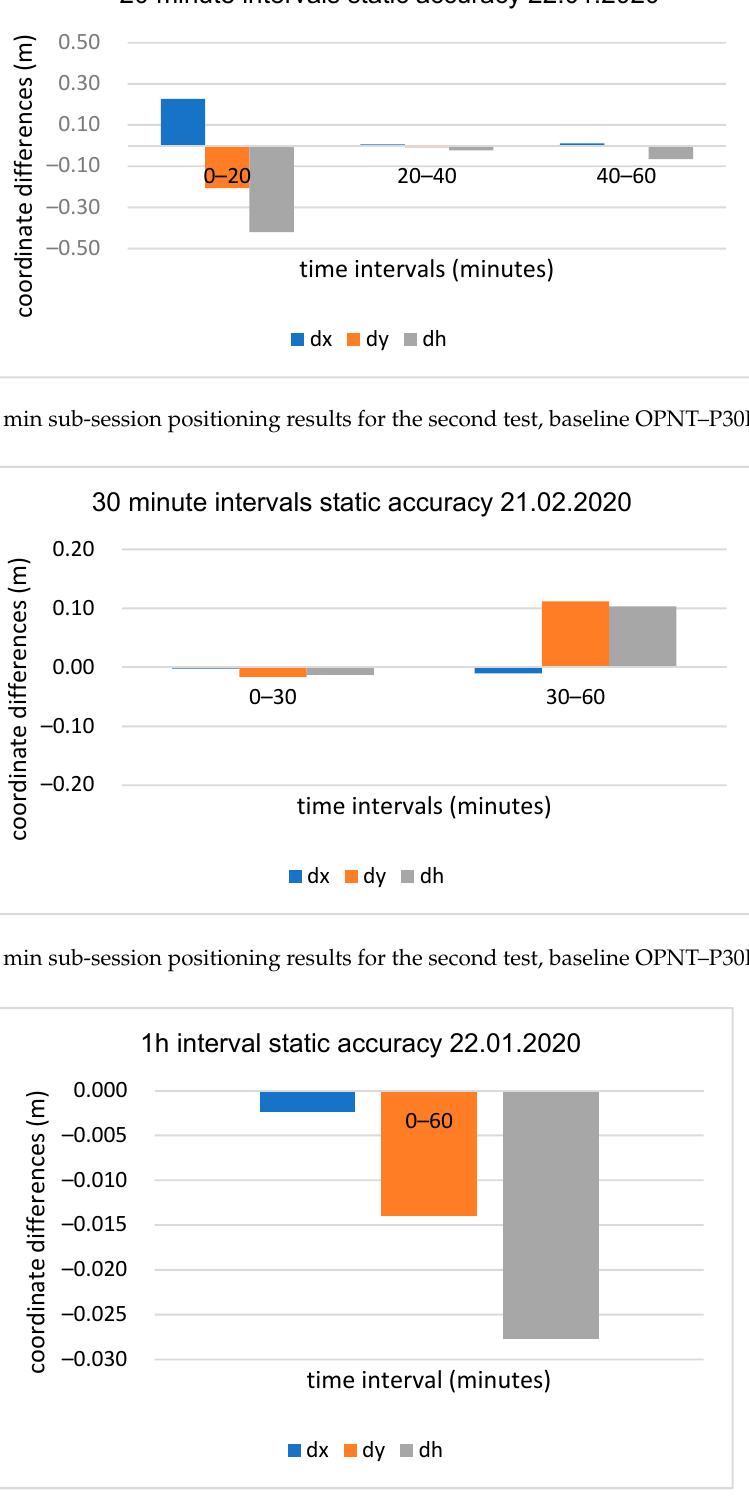
Figure 15. 60 min session positioning results for the second test, baseline OPNT–P30Pro (4 km). Table 6. 10 min sub-session positioning results summary, baseline OPNT–P30Pro (4 km).